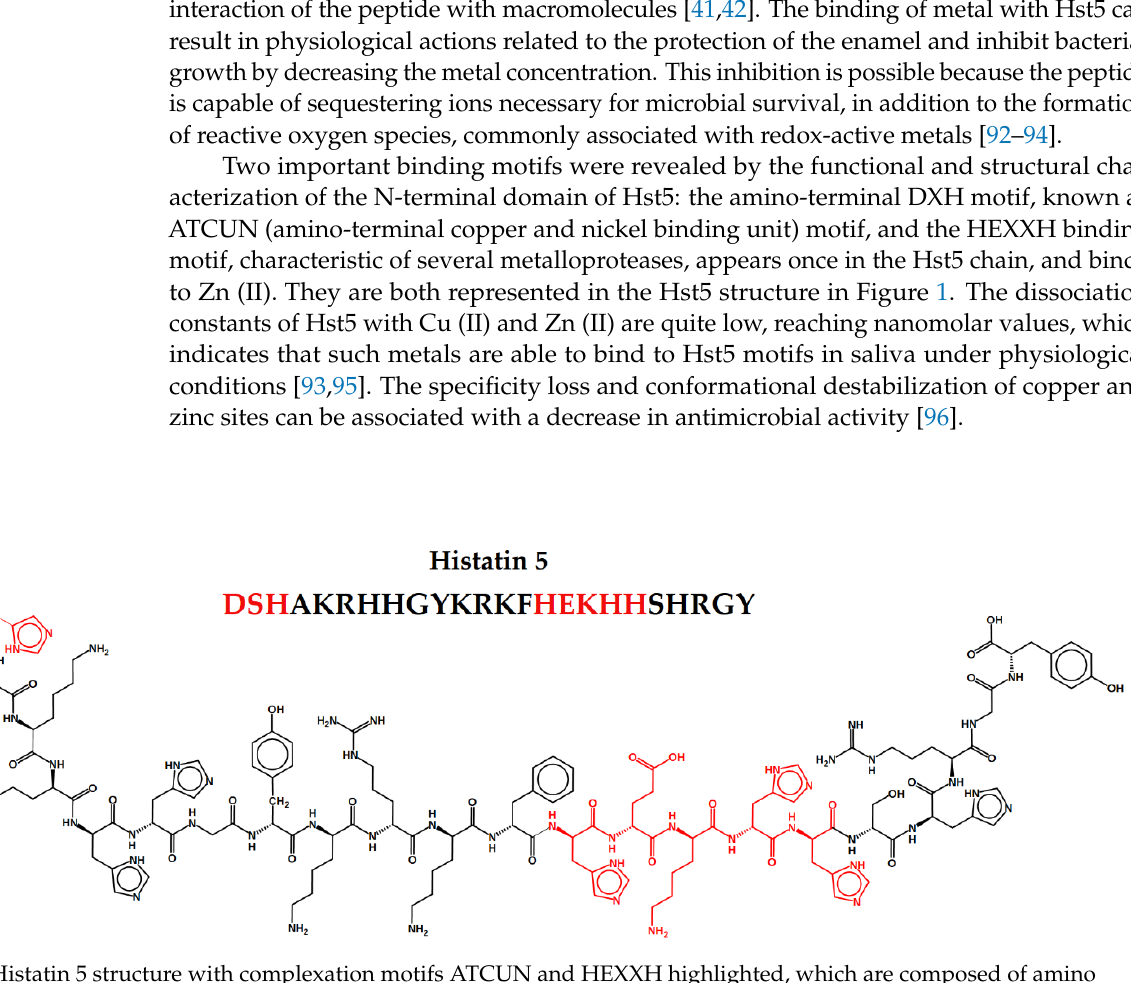
Figure 1. Histatin 5 structure with complexation motifs ATCUN and HEXXH highlighted, which are composed of amino acids such as histidine (H), serine (S), aspartic acid (D) and glutamic acid (E), known for metallic complexation.